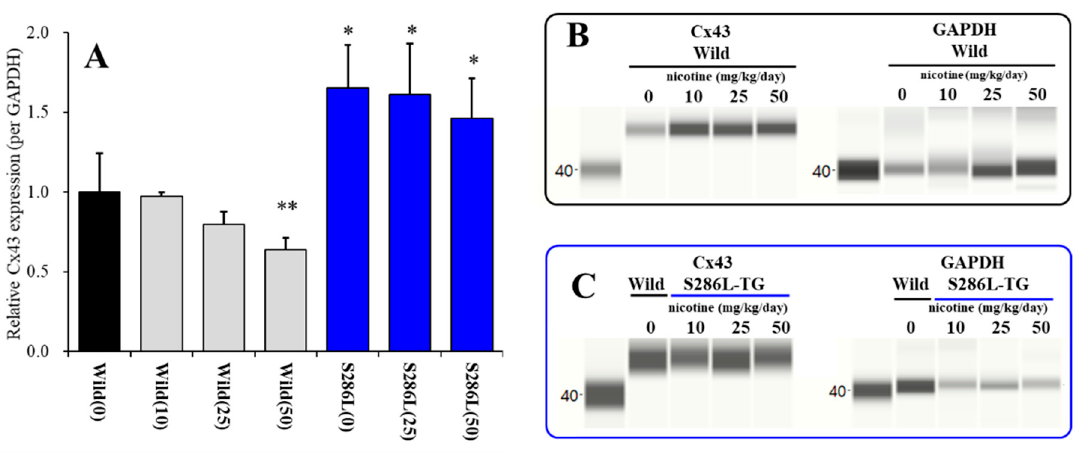
Figure 2. Dose-dependent effects of subcutaneous administration of subchronic doses of nicotine (0, 10, 25 and 50 mg/kg/day) for 7 days on Cx43 expression in the M2C plasma membrane fraction of wild-type and S286L-TG ( A ) and pseudo-gel images using Simple Western using anti-GAPDH and anti-Cx43 antibody for blotting of plasma membrane fractions of wild-type ( B ) and S286L-TG rats ( C ). In panel 2A, ordinate: mean ± SD (n = 6) of relative protein level of Cx43. * P < 0.05, ** P < 0.01 relative to nicotine free wild-type by one-way analysis of variance (ANOVA) with Tukey’s post hoc test.